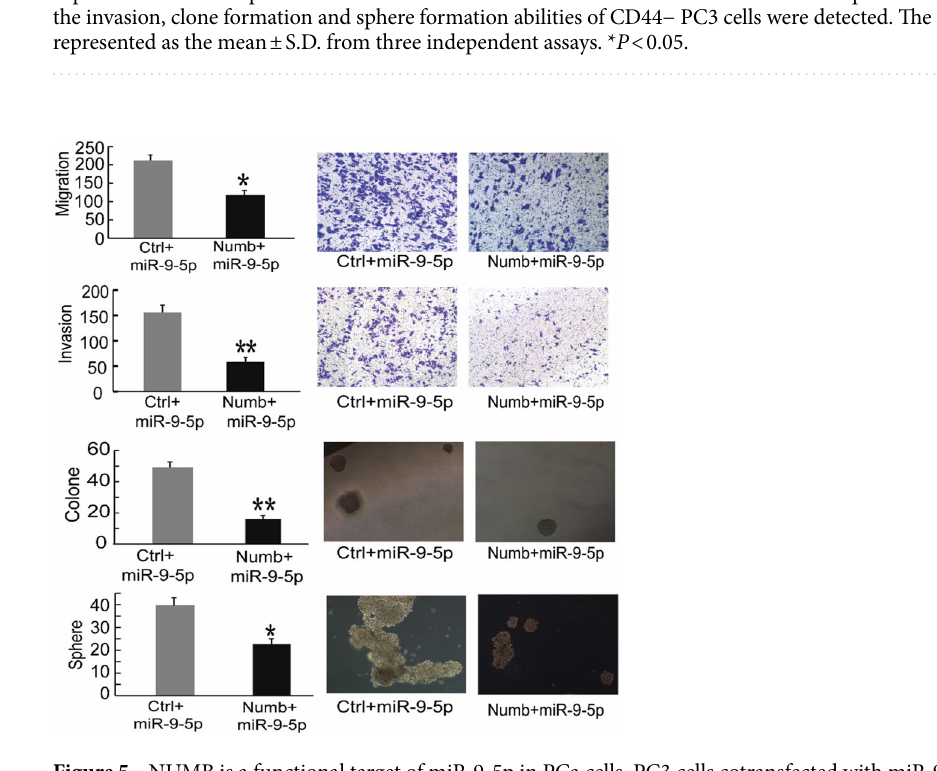
Figure 5. NUMB is a functional target of miR-9-5p in PCa cells. PC3 cells cotransfected with miR-9-5p mimic and NUMB cDNA lacking the NUMB 3’-UTR restored the expression of NUMB after 48 h of culture. From the upper part of the figure to the lower part of the figure, the migration, invasion, clone formation and sphere formation abilities of the cotransfected PC3 cells were detected. The results are represented as the mean ± S.D. from three independent assays. * P < 0.05, ** P <